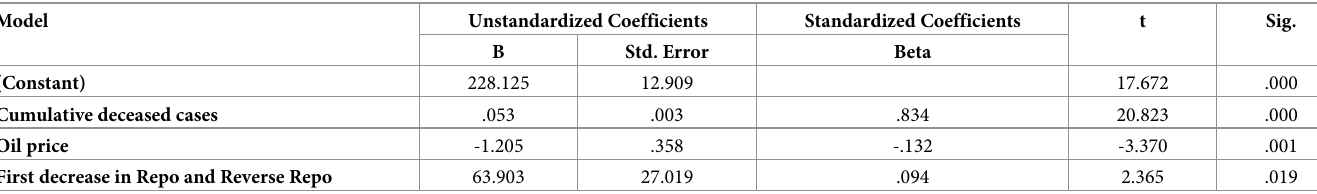
Table 9. Coefficients of the reduced linear regression model without multicollinearity. Model